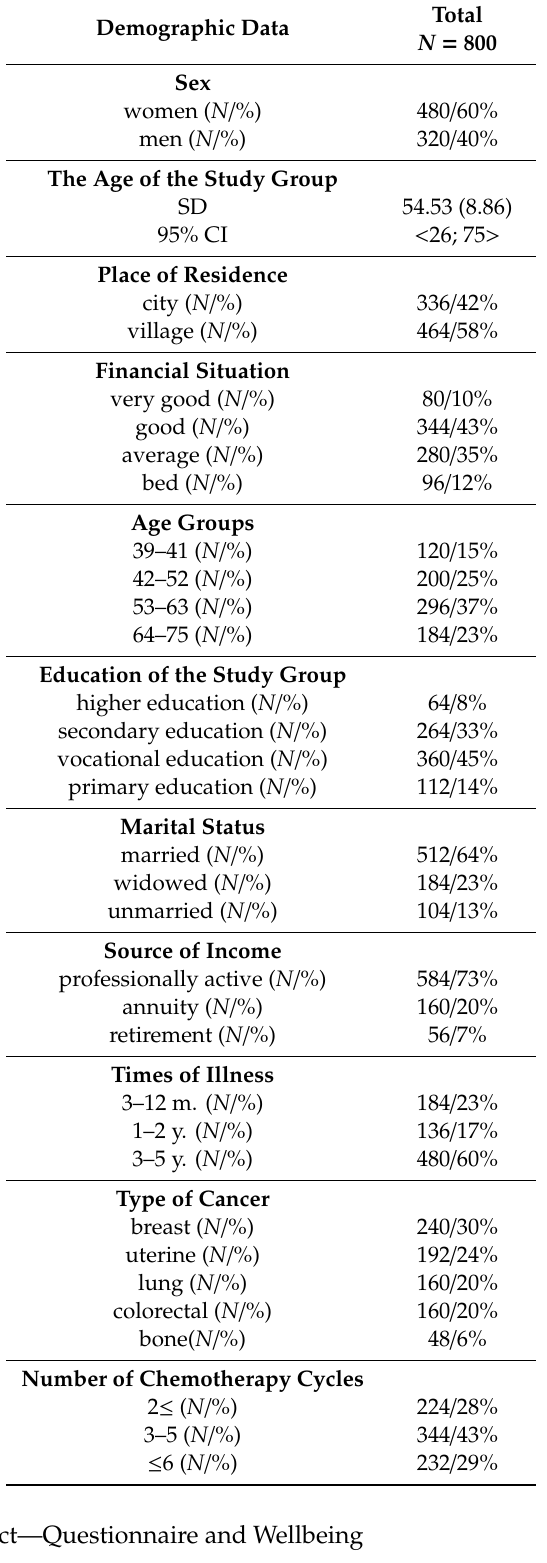
Table 1. Descriptive statistics of the examined group of